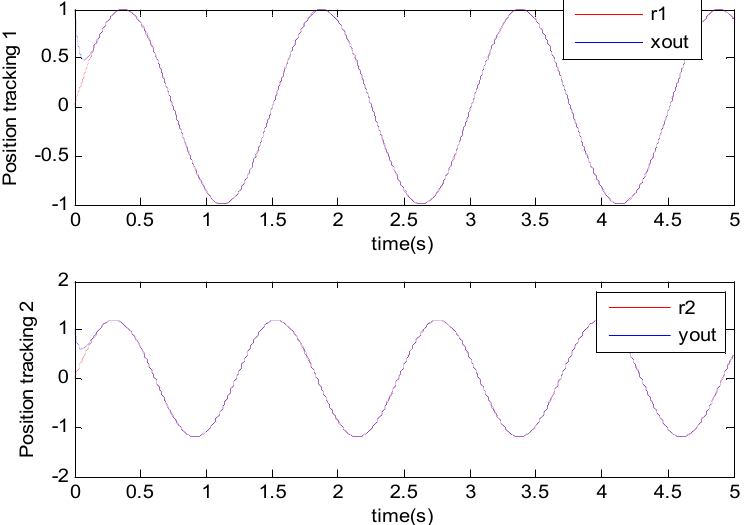
Figure 3. Trajectory tracking using the ABFSMC approach.